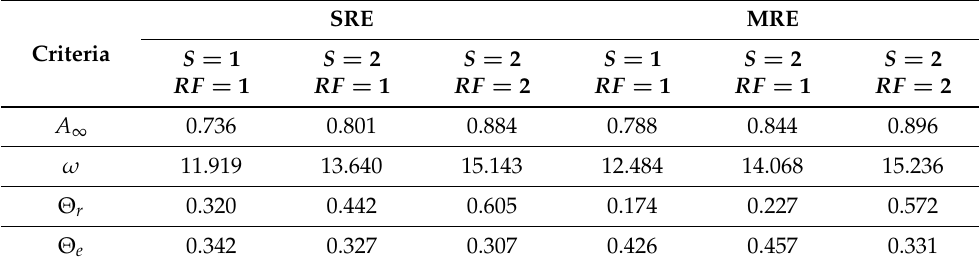
Table 1. Calculated results under RPT